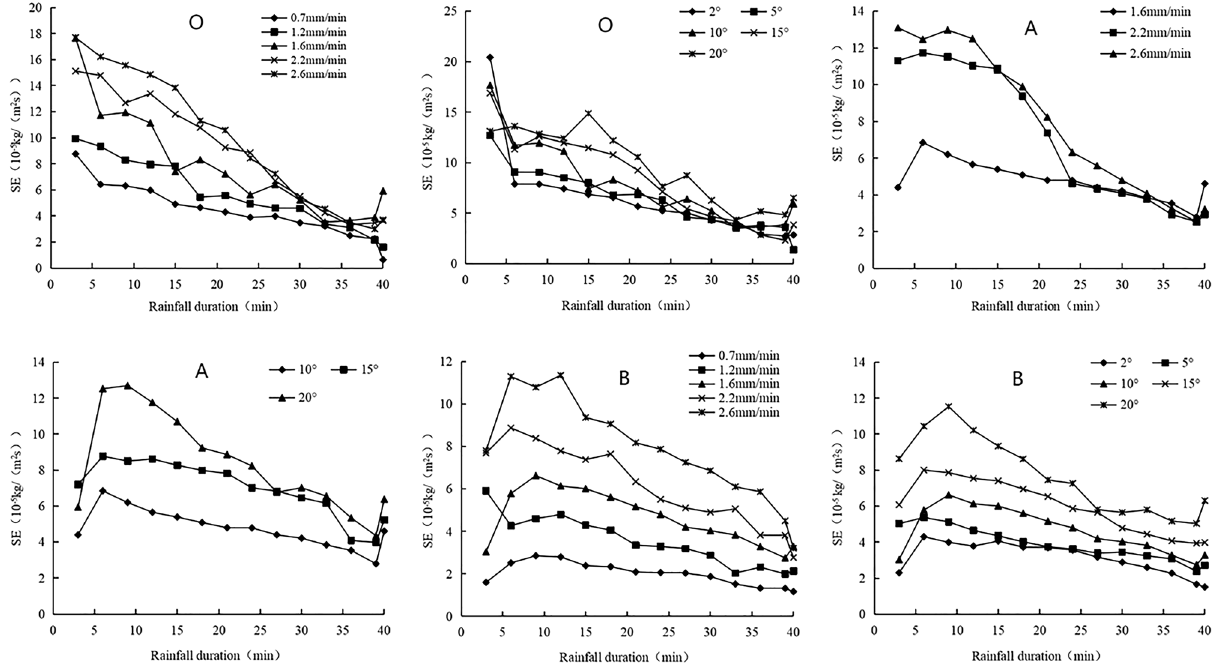
Figure 3. Variations of sheet erosion rate with rainfall duration in different treatments. O is bare slope, B is Prunella vulgaris combined with earthworm planting slope, A is Single planting prunella vulgaris slope.